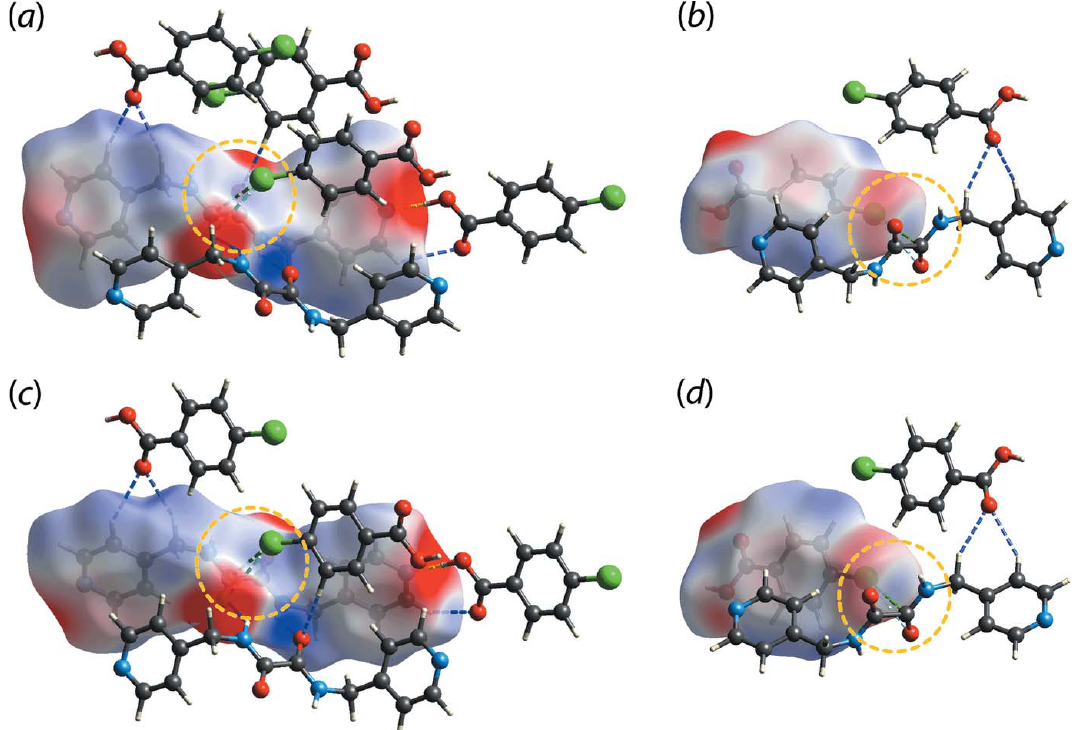
Figure 5 The electrostatic potential mapped onto the Hirshfeld surfaces within the isosurface value of (cid:4) 0.0416 to 0.0981 atomic units for ( a ) 4 L H 2 -I, ( b ) CBA-I, ( c ) 4 L H 2 -II and ( d ) CBA-II. The circles highlight the interactions between the electronegative sites of the amide and the chlorine atoms through the electropositive (cid:2) -hole